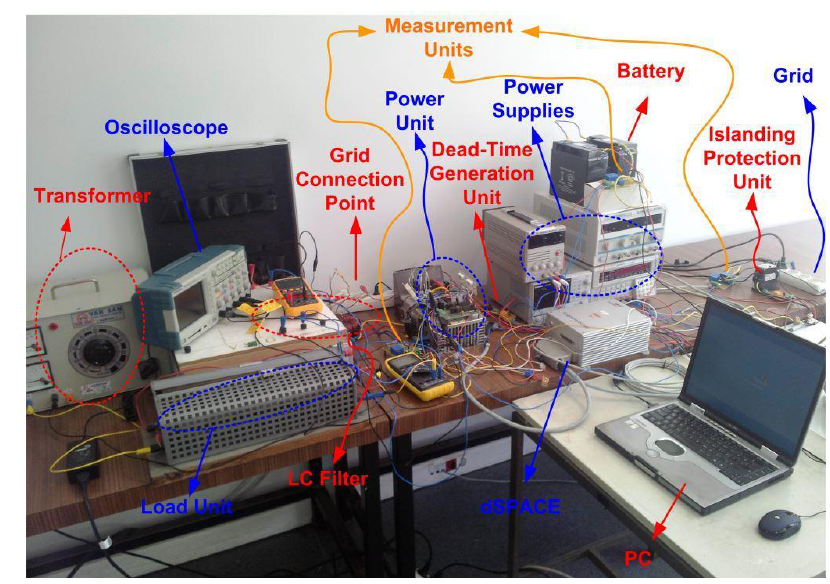
Figure 6. General scheme of the test platform. Table 2. Parameters of the test platform.